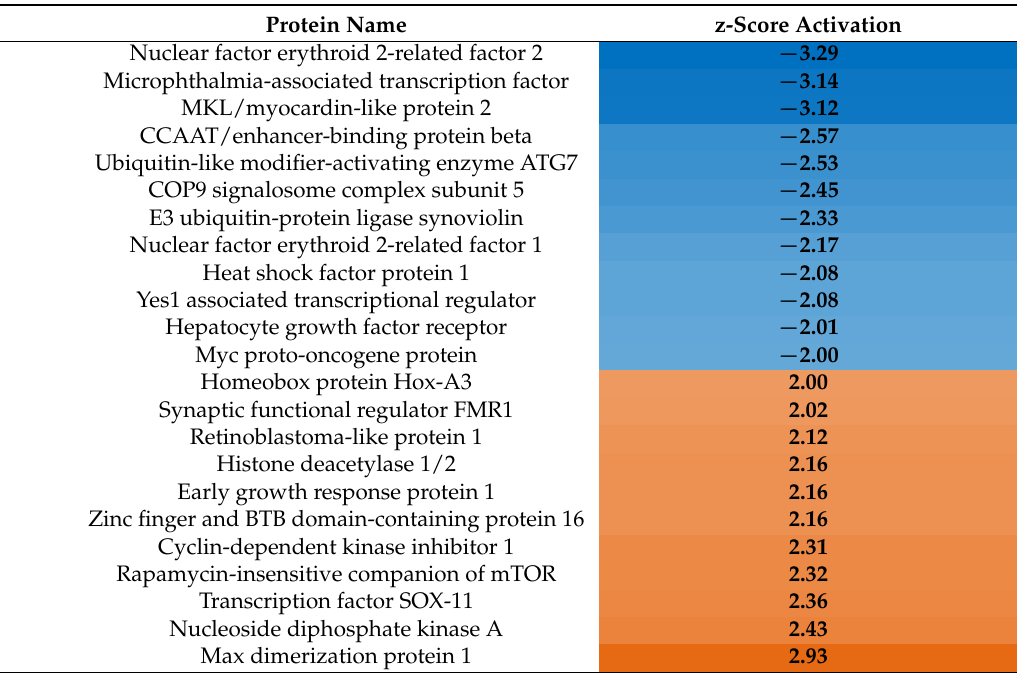
Table 2. List of the main differential upstream regulators. Activated or inhibited gene regulators in the comparison of OCI-AML 3 shNS/OCI-AML 3 SCR cells. Table reports the predictive z-scores (orange: activation, with significant z-score ≥ 2.00; blue: inhibition, with significant z-score ≤ − 2.00). Color is proportional to z-score value. The CDKN1A upstream regulator is highlighted in bold because it was further